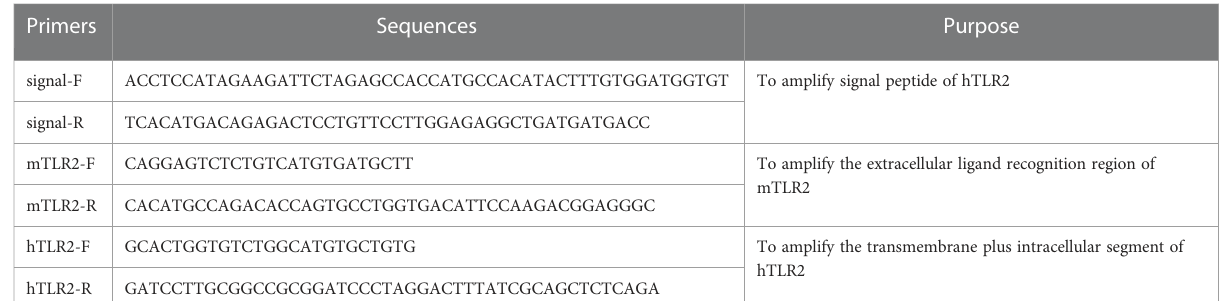
TABLE 1 The sequences of primes used to amplify the target segments of